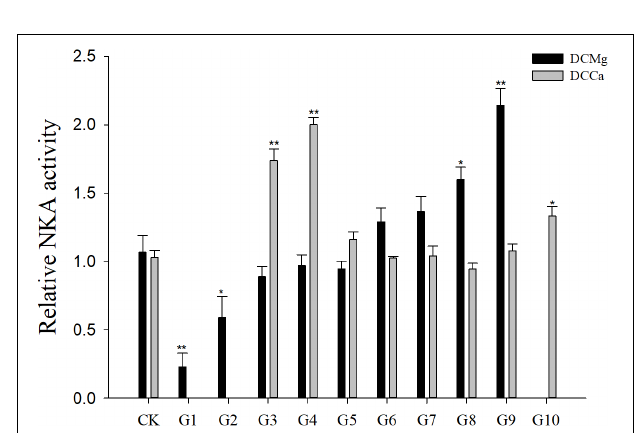
FIGURE 2 | Daily shell length growth rate of JSCs under long-term stress with different Ca 2 + and Mg 2 + concentrations. Bars (mean ± SE, n = 3) with an asterisk denote a significant difference ( ∗ P < 0.05, ∗∗ P < 0.001) between the test groups (G1–G10) and CK.